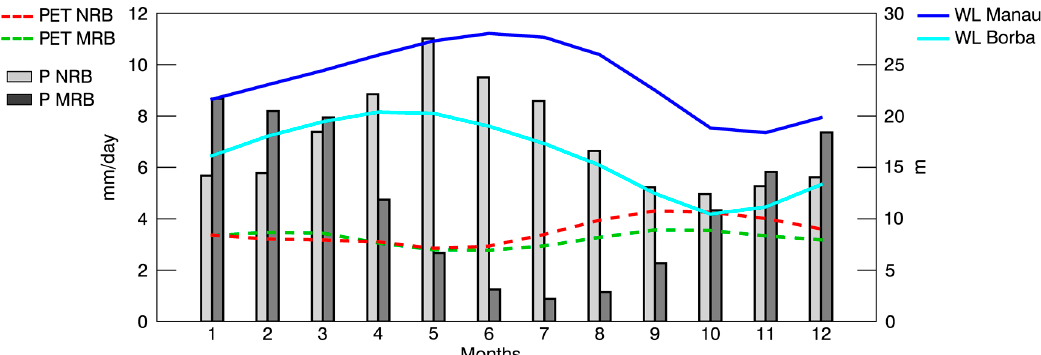
Figure 3. Precipitation (P; bars), potential evapotranspiration (PET; dashed lines) annual climatological cycle of the Negro and Madeira river basins (NRB and MRB, respectively). Annual water level cycle in Manaus and Borba (WL; solid lines). Period: 1980–2016.